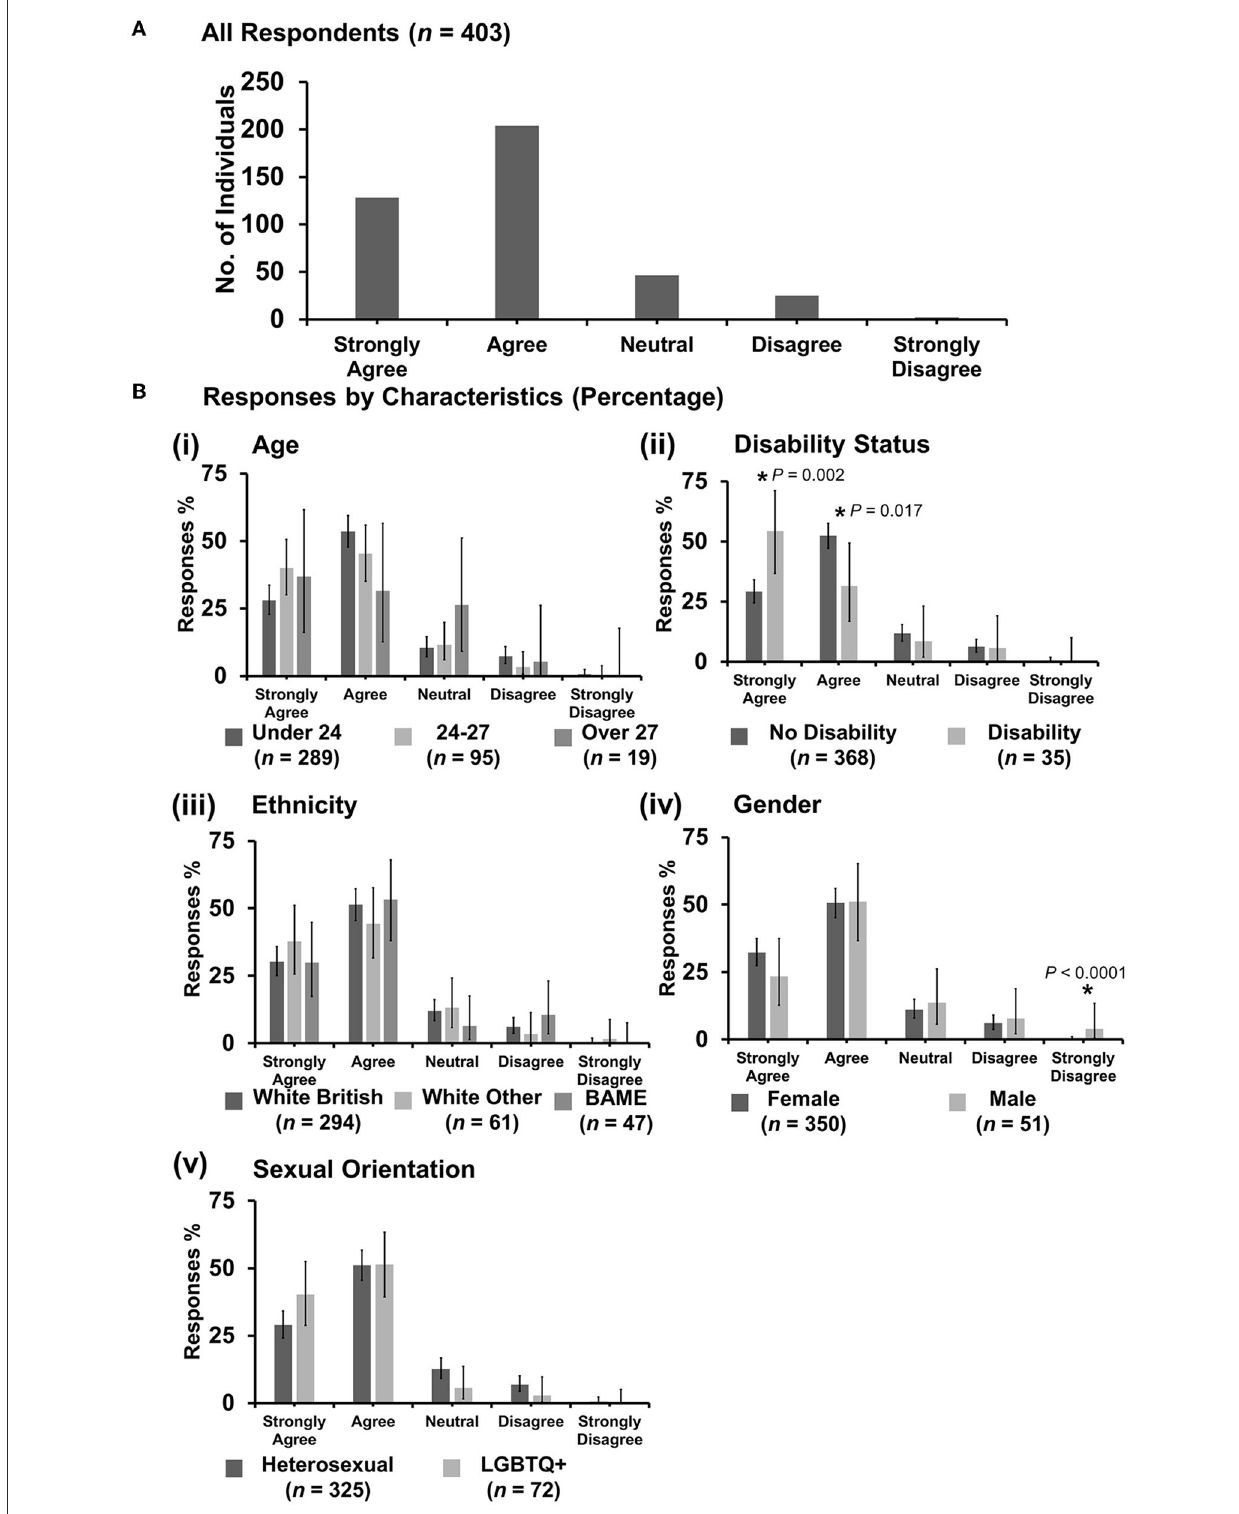
FIGURE14 Likert scale selections for the statement: veterinary students are less likely to report discrimination due to fear of consequences. (A) Bar graph demonstrating the number of respondents selecting each Likert scale response. [ (B) i–v] Bar graphs demonstrating by percentage proportion the number of responses in each Likert category by the group under the demographic categories of age, disability status, ethnicity, gender, and sexual orientation. Error bars represent 95% confidence intervals calculated by the Binomial “Exact” method. Statistical significance was determined by Pearson’s chi-squared test of association between respondent’s group under category and Likert scale selection. * P <